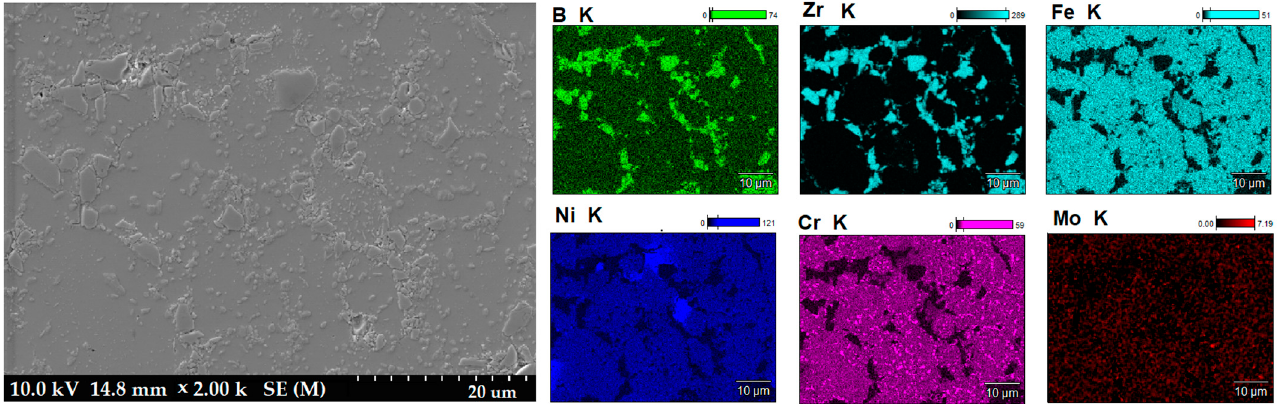
Figure 4. The SEM image of steel+10% ZrB 2 composite with WDS analysis.